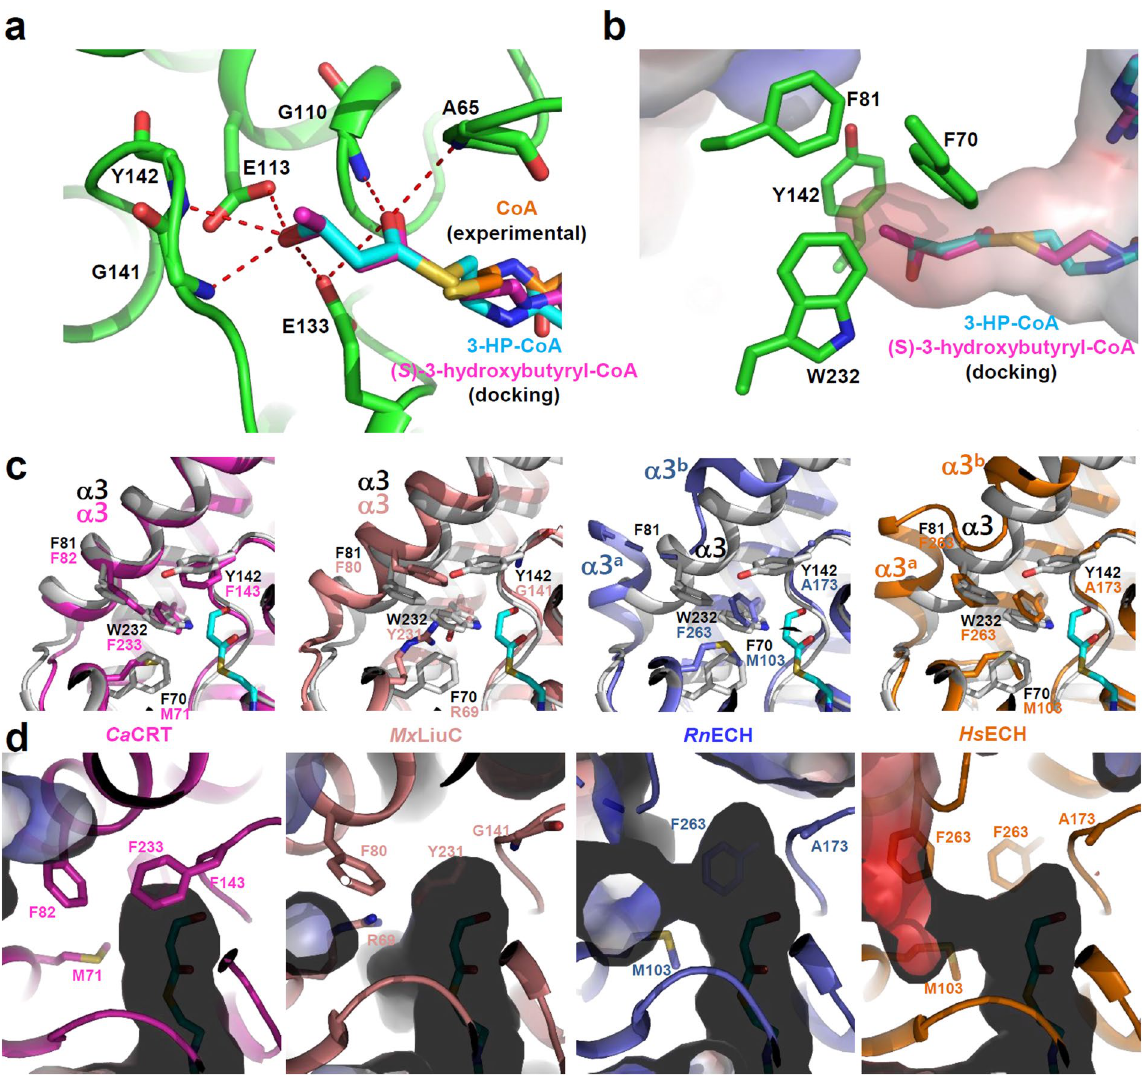
Figure 4. Substrate specificity of Ms 3HPCD. ( a ) 3-HP- and ( S )-3-hydroxybutyryl-moiety binding mode of Ms 3HPCD. The Ms 3HPCD structure is shown as a cartoon diagram with a green color. The residues involved in the formation of the 3-HP binding pocket are shown as stick models and labeled appropriately. The bound CoA, simulated 3-HP-CoA, and simulated ( S )-3-hydroxybutyryl-CoA are presented with stick models with colors of cyan, orange, and magenta, respectively. Hydrogen bonds involved in the 3-HP and ( S )- 3-hydroxybutyryl-moiety binding are shown as red-colored dotted lines. ( b ) Electrostatic potential surface model of the 3-HP binding pocket of Ms 3HPCD. The Ms 3HPCD structure is shown as an electrostatic potential surface presentation. The simulated 3-HP-CoA and ( S )-3-hydroxybutyryl-CoA are presented by a stick model with cyan and magenta colors. The residues involved in the formation of the 3-HP binding pocket are shown as stick models with a green color. ( c ) Structural comparison of Ms 3HPCD with Ca CRT, Mx LiuC, Rn ECH, and Hs ECH. The structure of Ms 3HPCD is superposed with each of those of Ca CRT, Mx LiuC, Rn ECH, and Hs ECH. The structure of Ms 3HPCD is shown with a gray color, and those of Ca CRT, Mx LiuC, Rn ECH, and Hs ECH are with colors of magenta, salmon, light-blue, and orange, respectively. The residues involved in constitution of the enoyl-binding pocket are shown as stick models. ( d ) Electrostatic potential surface model of the 3-HP binding pocket of other ECHs. The structures of Ca CRT, Mx LiuC, Rn ECH, and Hs ECH are shown as cartoon models and electrostatic potential surface presentations with color scheme same as in ( c ). The residues involved in the formation of the enoyl-binding pocket are shown as stick